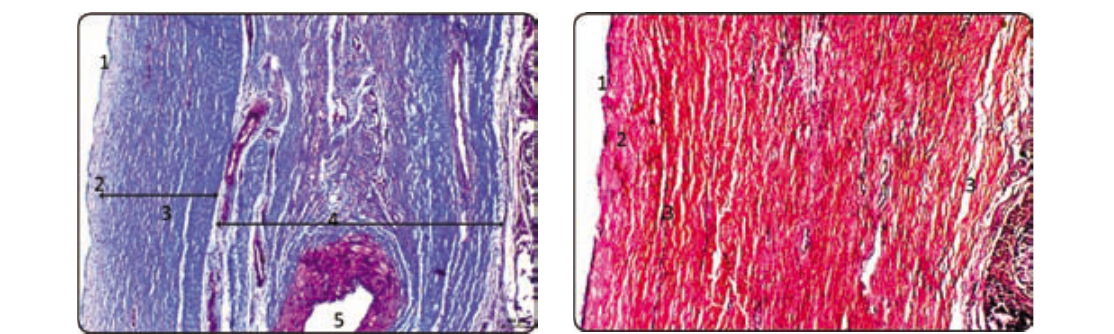
Fig. 2. Cross section of testicular capsule with visceral layer of tunica vaginalis.